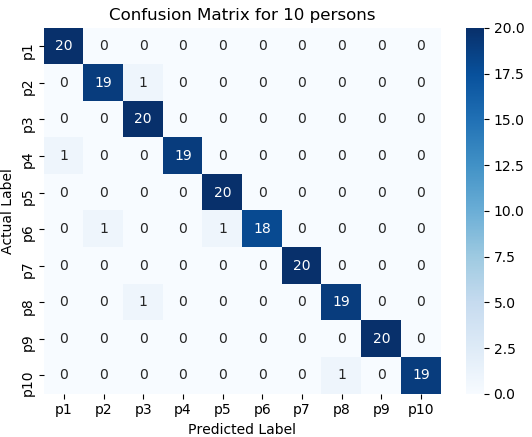
Figure 11. Confusion matrix of the proposed model for the five persons.